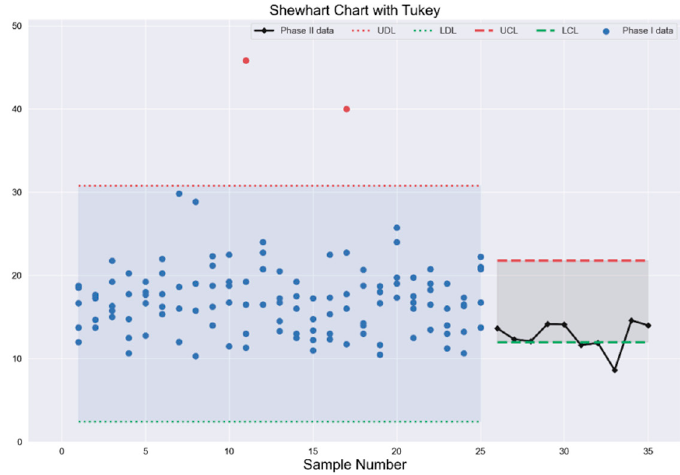
Figure 10. Scatter plot of phase-I sample and the resulting Shewhart chart with Tukey outlier detection screening.